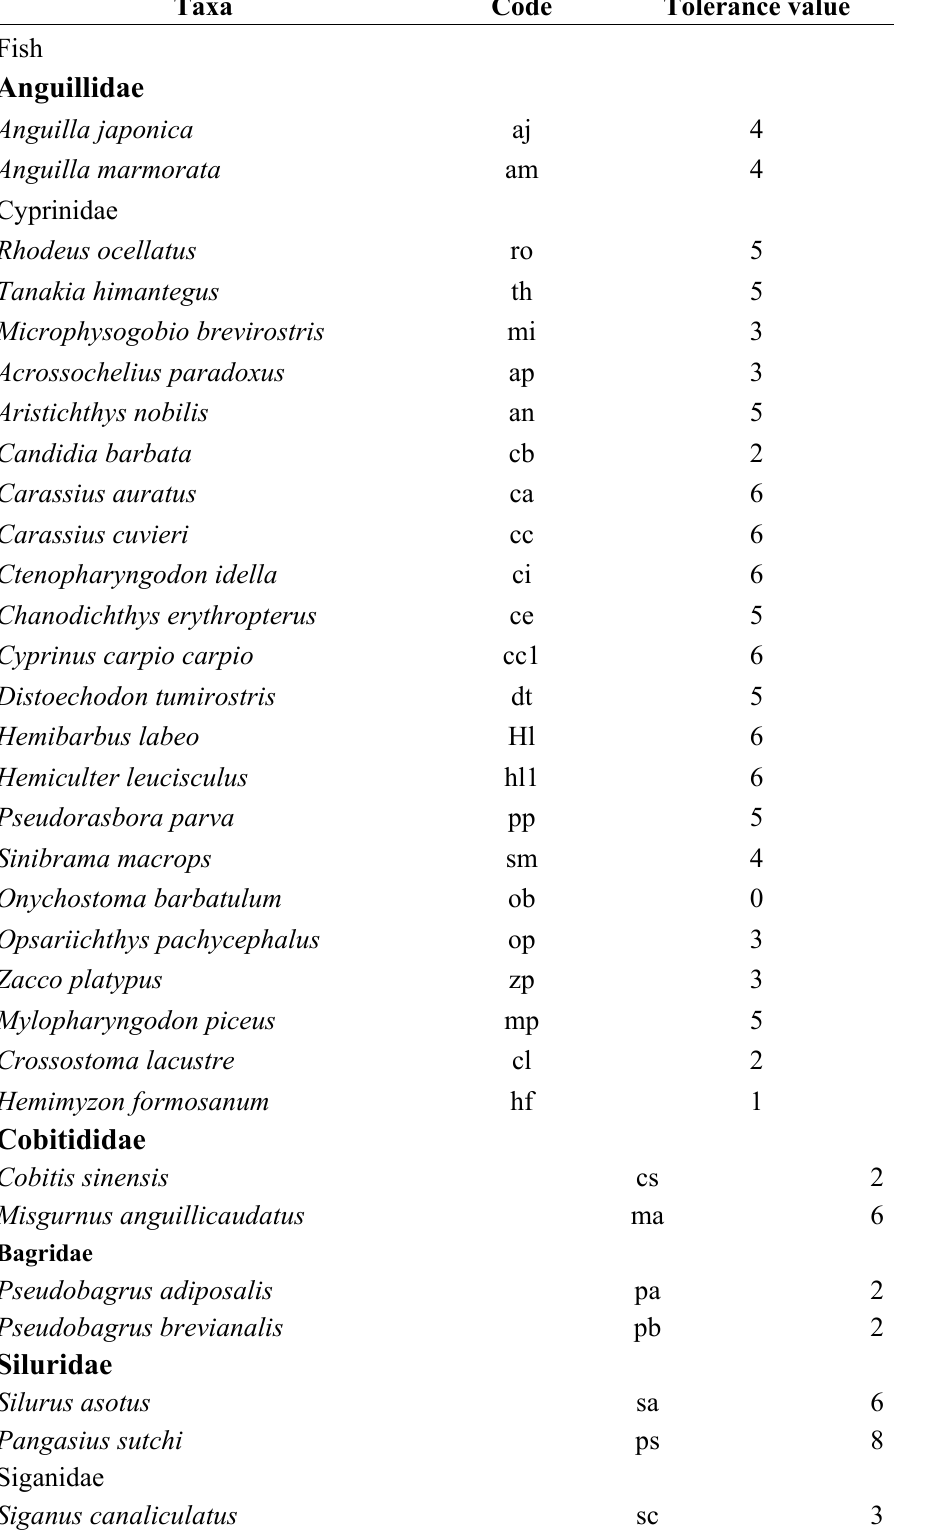
Table A2. Fish taxa and macroinvertebrate taxa, code for Figures 3–5 and pollution tolerance values used in biological indication for Figures 6–8 are